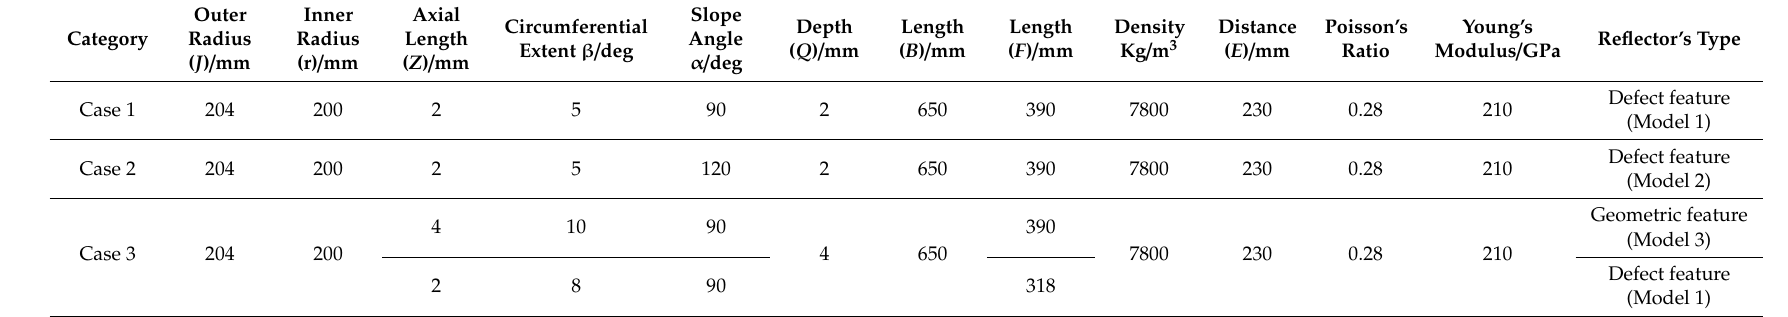
Table 3. Geometrical and physical parameters of the sample